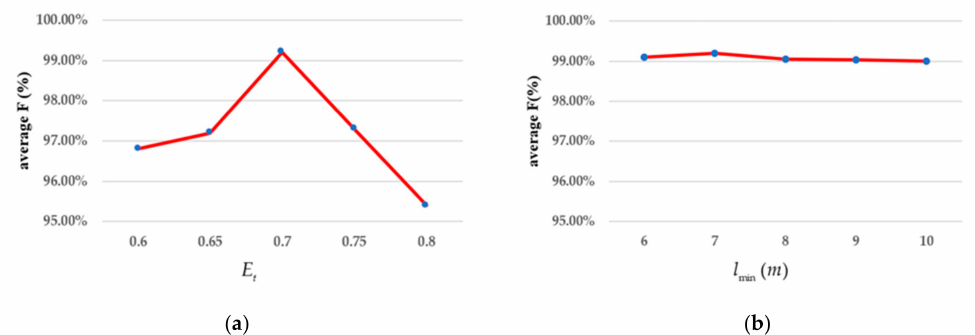
Figure 9. Performance testing for different empiric parameters. The other parameters were set as in Table 4. ( a ) The accuracy of the minimum length of line; ( b ) the accuracy of the evaluation